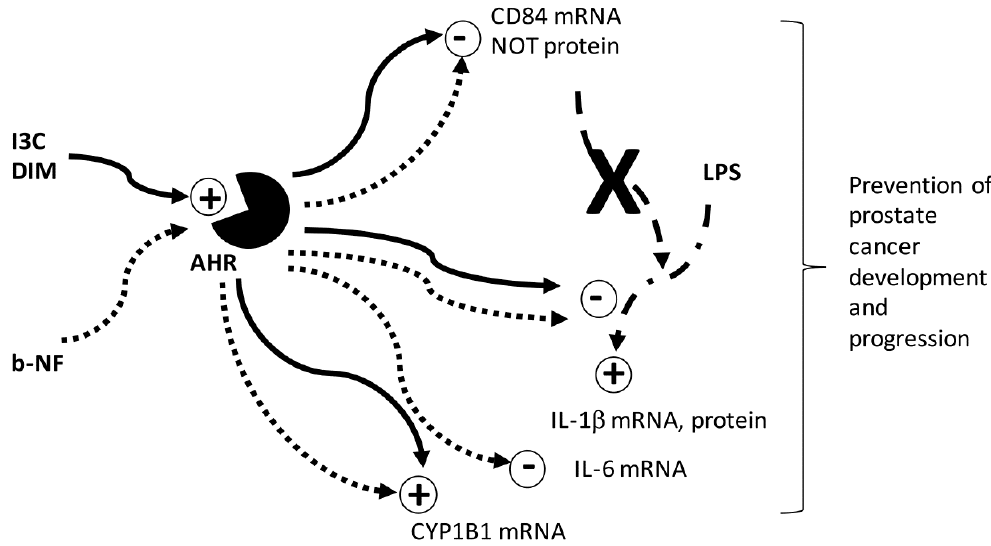
Figure 9. Working Model for regulation of prostate cancer. Schematic diagram shows the proposed mechanism underlying the inhibitory effects of I3C and DIM on LPS induction of IL-1 β mRNA and protein, mediated through AHR, and not the CD84-mediated pathway. I3C and DIM down-regulated CD84 mRNA, but not protein levels in an AHR-dependent manner. Activation of AHR is indicated by upregulation of CYP1B1, a well-documented AHR-responsive gene. The classic AHR ligand, b-NF, exerts similar effects as I3C/DIM on IL-1 β , CD84, and CYP1B1 mRNA, but only b-NF inhibited LPS-induction of IL-6 mRNA levels. Solid line: Effects of I3C/DIM. Dotted line: Effects of b-NF. Bold X: Based on our data, the pathway does not occur. DIM is known to be an acid condensation product of I3C. The effectiveness of I3C and DIM on the pathway examined is best differentiated by dose dependence of the compounds. Specifically, DIM elicits an effect at a much lower concentration than I3C. However, our results indicate that both I3C and DIM can influence the AHR pathway. Hence, I3C and DIM may directly influence immune cells and also modulate cancer cell-stromal cell interaction to exert their cancer protective effects. The overall effect would reduce monocyte/macrophage infiltration, inflammation and potential for angiogenesis in the prostatic tumor. Further investigations are necessary to validate this hypothesis in vivo in prostate cancer.